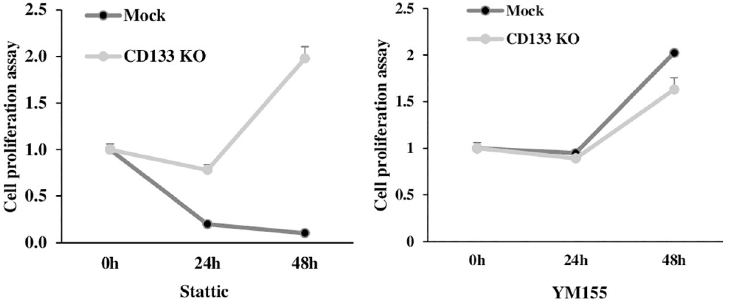
Fig 3. The stattic treatment induced much more inhibitory effect on cell proliferation of CD133 + cells than CD133 knockout cells (P < 0.001). However, the effect of YM155 was not significantly different between CD133 + cells and CD133 knockout